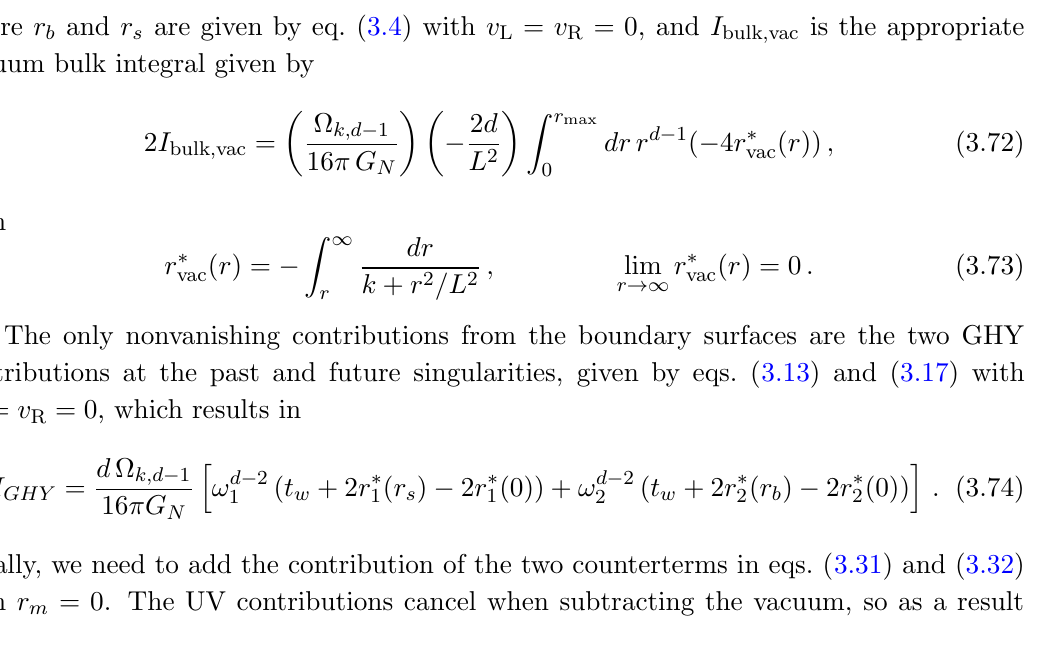
Figure 6. Penrose-like diagram for one shock wave sent from the right boundary at v eternal black hole geometry, with the Wheeler-DeWitt patch anchored at t L = t R = 0, which we will call the complexity of formation, in analogy to the case studied in [22] of the unperturbed eternal black hole geometry. There are two coordinates r b and r s that are usually given by a transcendental equation as functions of w and t w , as shown in eq. (3.4). The e(cid:11)ect of crossing the collapsing shell from the right boundary is to increase the surface of the WDW patch above the past